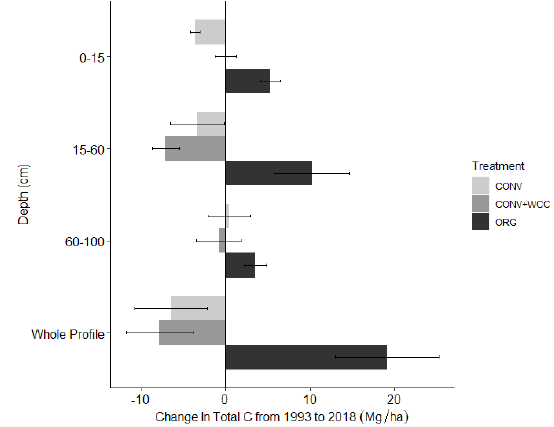
Figure 4. Depth equivalent of water (cm) in the upper 1m of ORG, CONV + WCC, and CONV profiles during the January–March 2019 winter season. Error bars represent standard error.